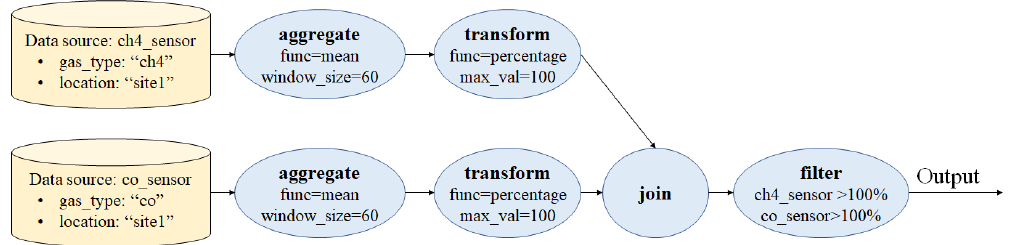
Figure 6. A query DAG of corresponding query shown on Figure